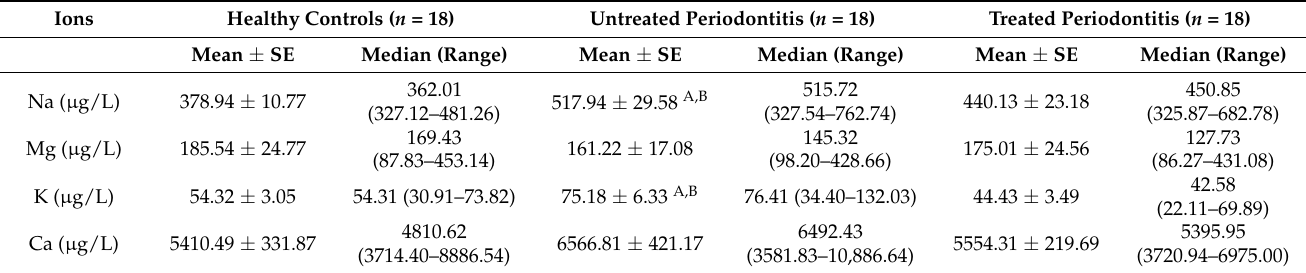
Table 2. Distribution of chemical elements in GCF.